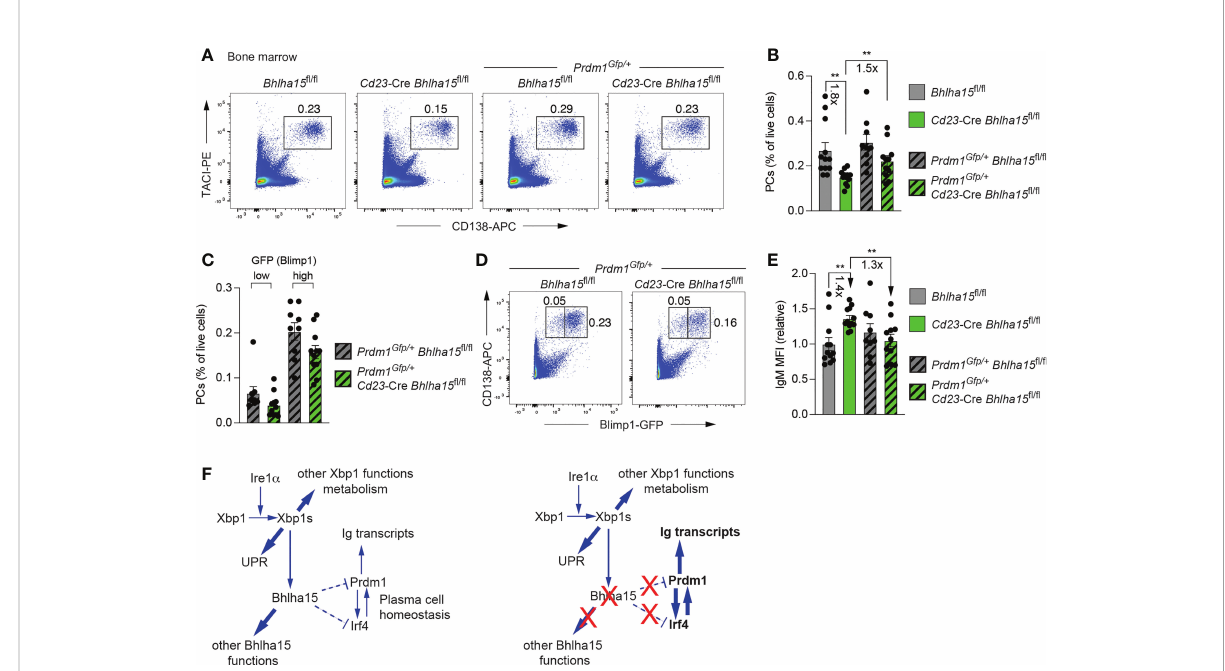
FIGURE 6 Reduced Blimp1 expression rescues the cell number and antibody secretion of Mist1-de fi cient plasma cells. (A) Flow-cytometric analysis of PCs (TACI + CD138 + ) in the bone marrow of unimmunized 10-13-week-old mice of the indicated genotypes. The percentage of cells in the gate is indicated. One of two independent experiments is shown. (B) Frequency of bone marrow PCs in unimmunized mice of the indicated genotypes. The frequencies were calculated based on the data of two independent experiments performed with Bhlha15 fl / fl ( n = 12), Cd23 -Cre Bhlha15 fl / fl ( n = 12), Prdm1 Gfp/+ Bhlha15 fl / fl ( n = 9) and Prdm1 Gfp/+ Cd23 -Cre Bhlha15 fl / fl ( n = 11) mice. (C, D) Flow cytometric analysis of GFP (Blimp1) expression in PCs (GFP + CD138 + ) from the bone marrow of Prdm1 Gfp/+ Cd23 -Cre Bhlha15 fl / fl and control Prdm1 Gfp/+ Bhlha15 fl / fl mice (D) . Frequency of GFP hi and GFP lo PCs in the bone marrow of Prdm1 Gfp/+ Cd23 -Cre Bhlha15 fl / fl and Prdm1 Gfp/+ Bhlha15 fl / fl mice (C) . (E) Quanti fi cation of the mean fl uorescence intensity (MFI) of intracellular IgM staining in bone marrow PCs (TACI + CD138 + ) of unimmunized mice with the genotypes and mouse numbers described in (B) . The MFI data are shown relative to the mean value of the Bhlha15 fl / fl PCs (set to 1). (F) Model explaining how the loss of Bhlha15 (Mist1) in fl uences the regulatory networks controlling PC homeostasis and antibody secretion. Statistical data are shown as mean values with SEM and were analyzed with the unpaired Student ’ s t test ( B , C , E ); ** P < 0.01. Each dot (B, C, E) represents one